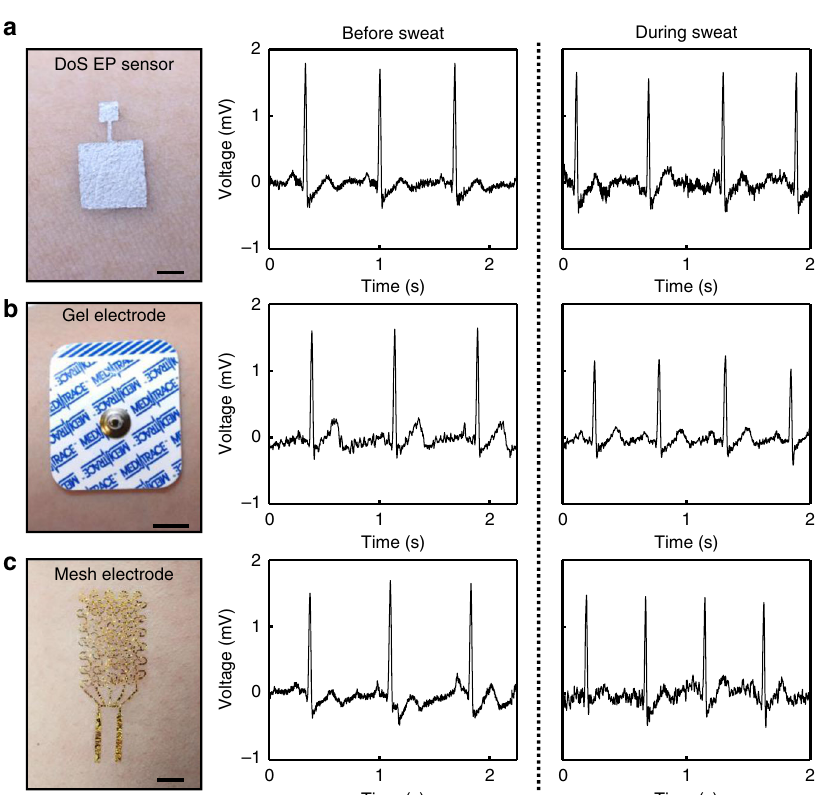
Fig. 4 Comparison of DoS electronics and existing technologies for ECG sensing before and during sweat conditions. a DoS EP sensor (left, scale bar 2 mm) with ECG signals recorded before sweating (middle) and while sweating (right). b Gel electrode (left, scale bar 1 cm) with ECG signals recorded before sweating (middle) and while sweating (right). c Mesh electrode (left, scale bar 5 mm) with ECG signals recorded before sweating (middle) and while sweating Supplementary Fig. 27 and Supplementary Fig. 28, respectively.